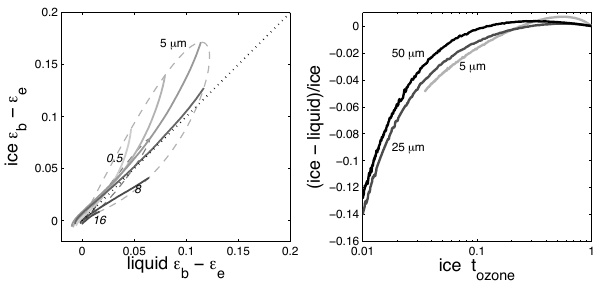
Fig. 5. Left: Range of r e (dashed: 5 and 10µm) and τ (solid: 0.5, 1, 2, 4, 8, 16) associated with the split-window difference ε b − ε e , depending on whether a cloud is assumed to be liquid or ice. The dotted line represents 1:1 perfect correspondence. For example, a r e = 5µm liquid droplet in a cloud with an optical depth τ of 1 has a split-window difference that is lower than an equivalent cloud com- posed of ice crystals. Right: The difference in transmissivity within the ozone band associated with cloud phase assumption as a func- tion of ozone band transmissivity t ozone and cloud r e .